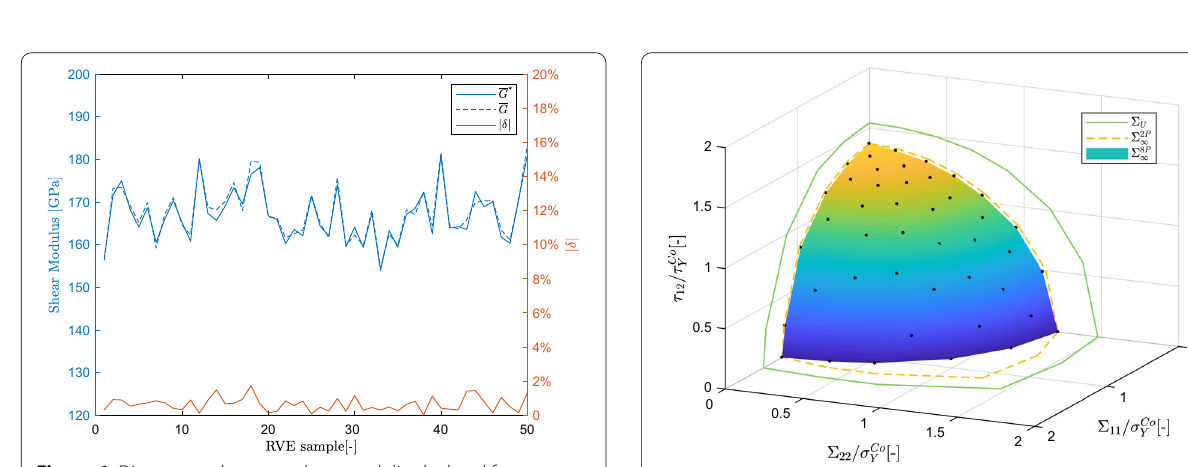
Figure 5 Correlation between homogenized elastic properties